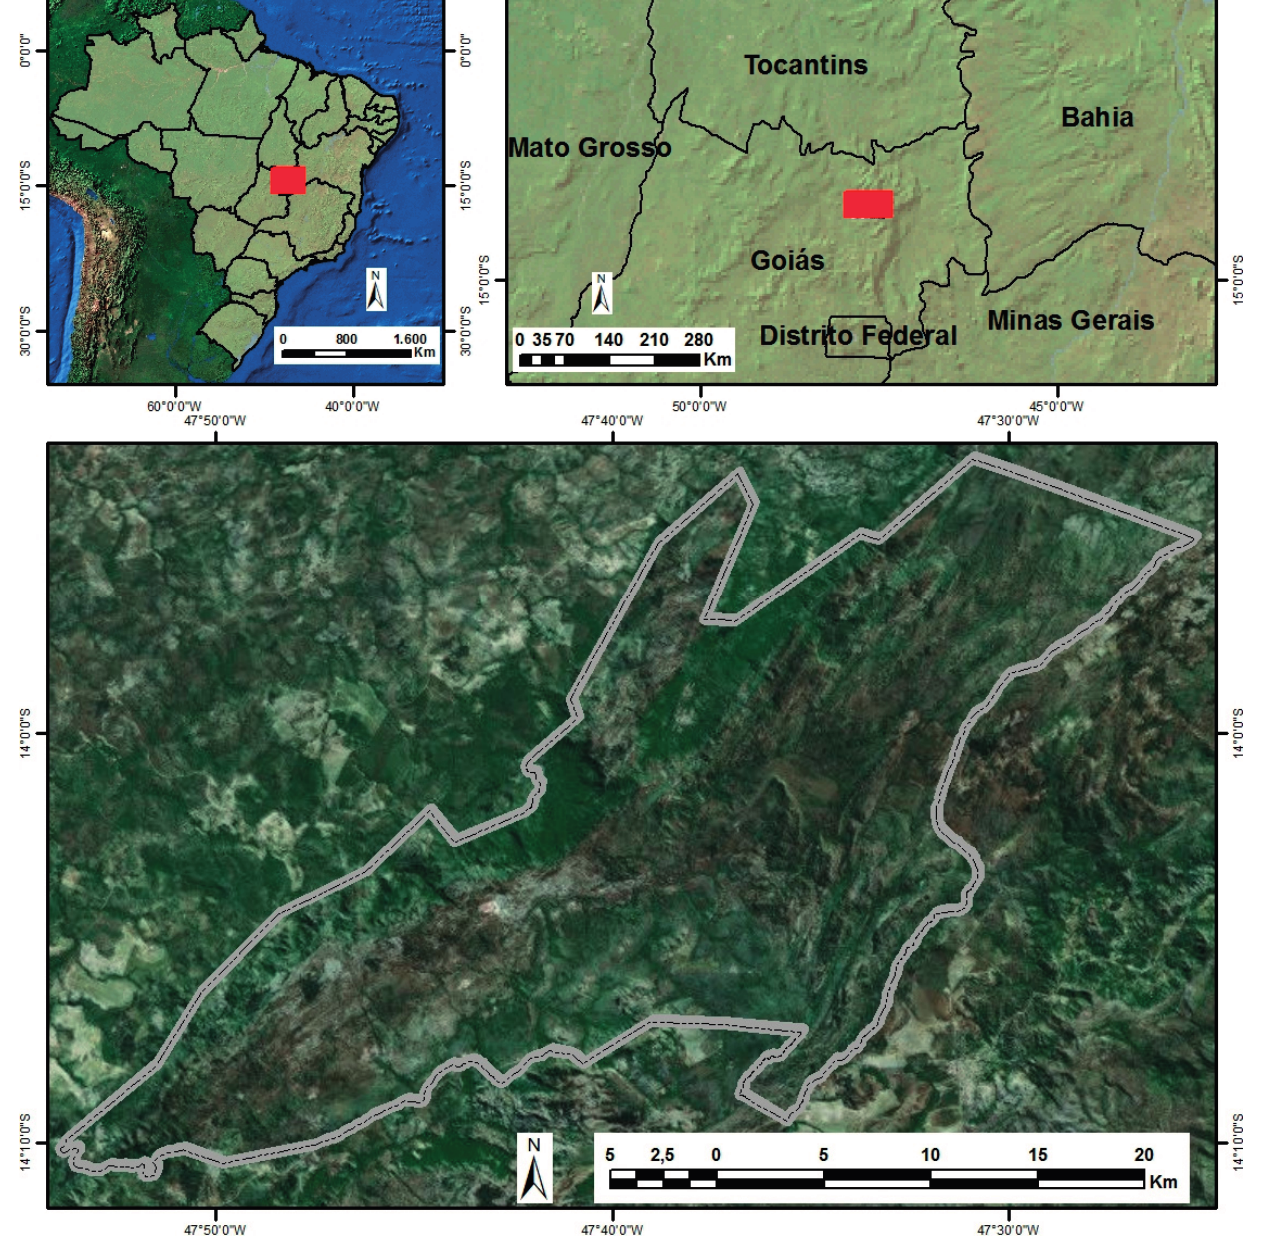
Figure 1. Chapada dos Veadeiros National Park